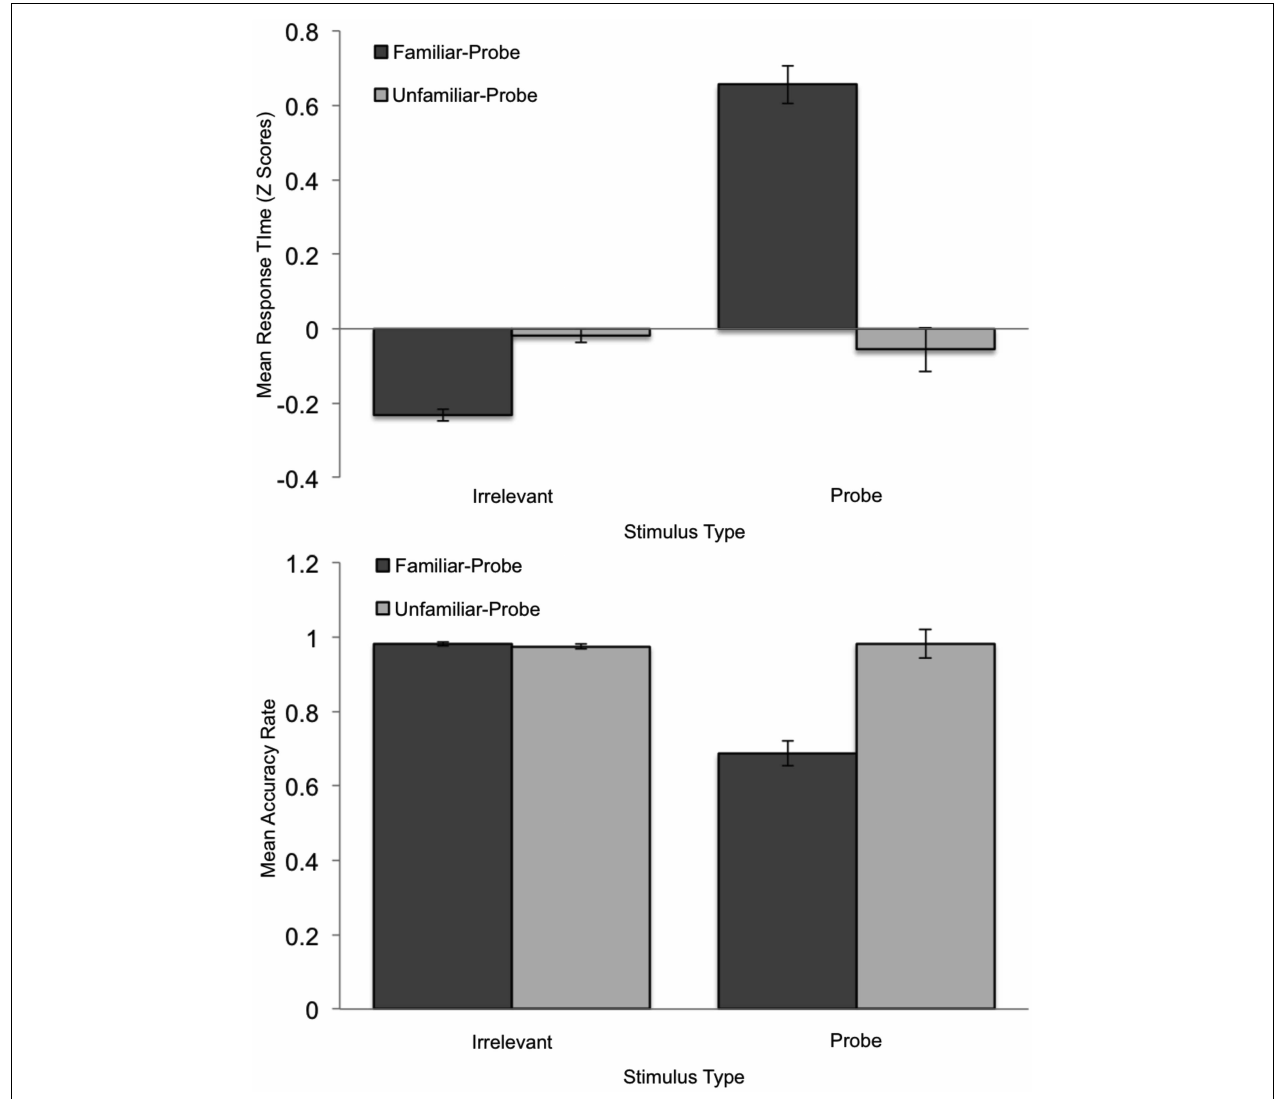
FIGURE 1 | Mean standardized RT (top graph) andAccuracy (bottom graph) plotted as a function of StimulusType and Condition. Error bars indicate standard error of the